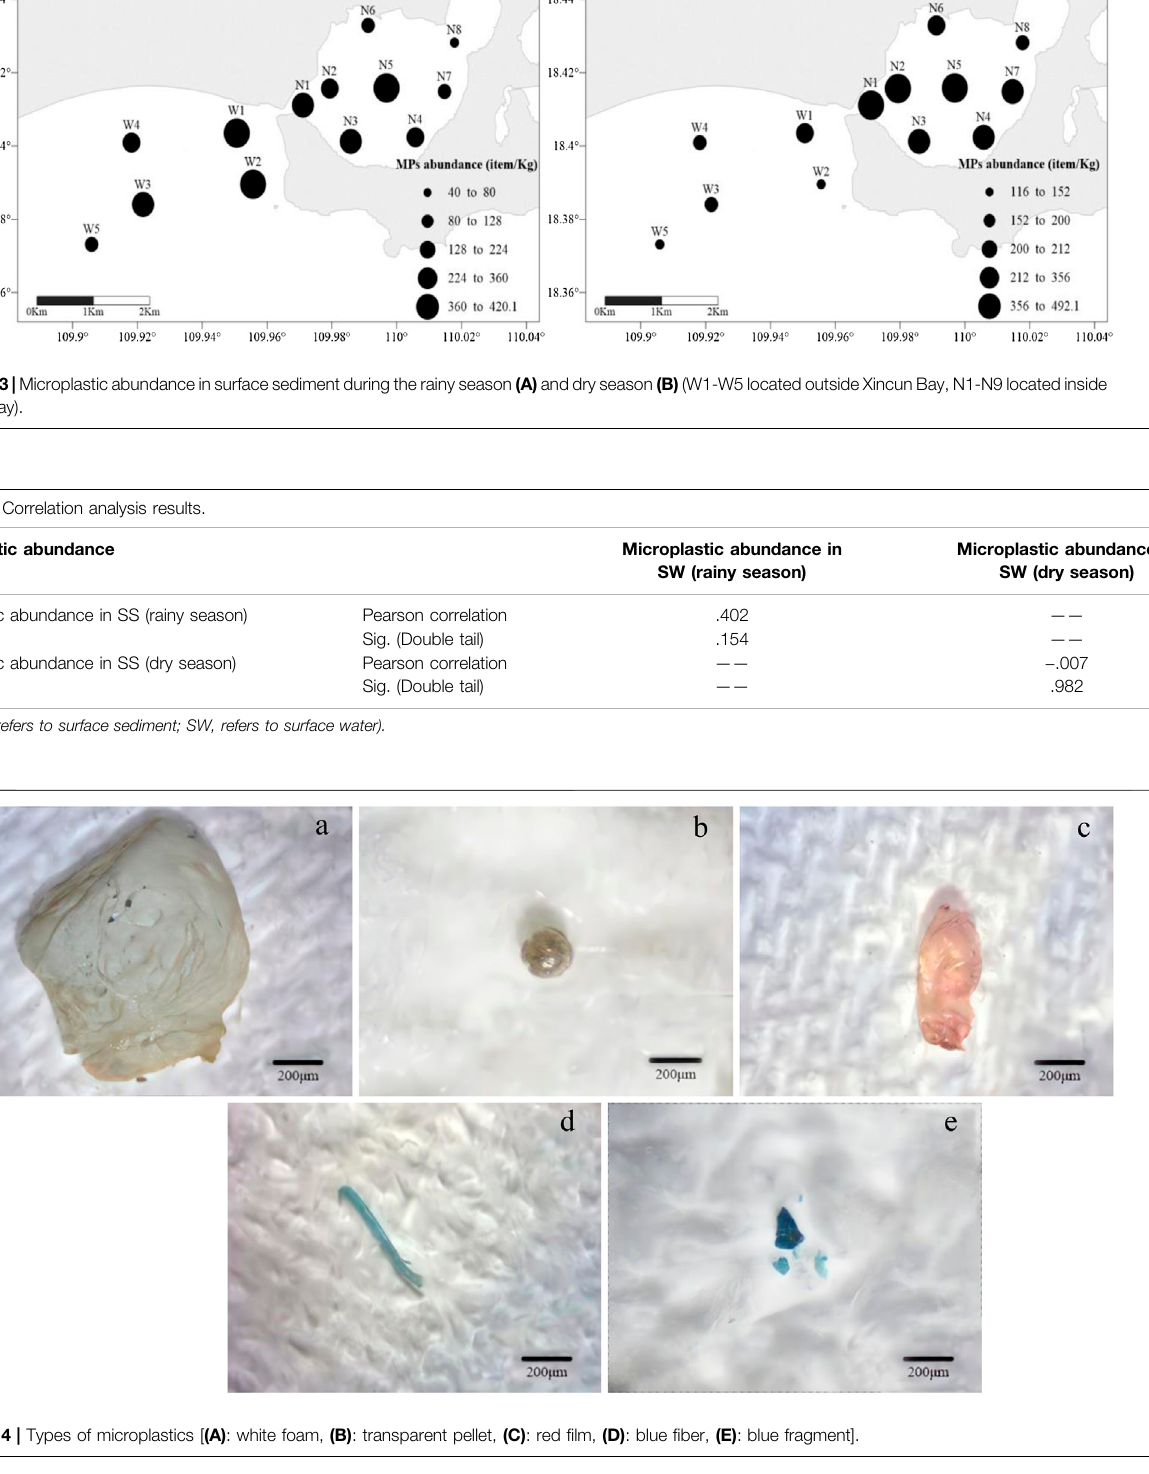
Frontiers in Environmental Science |